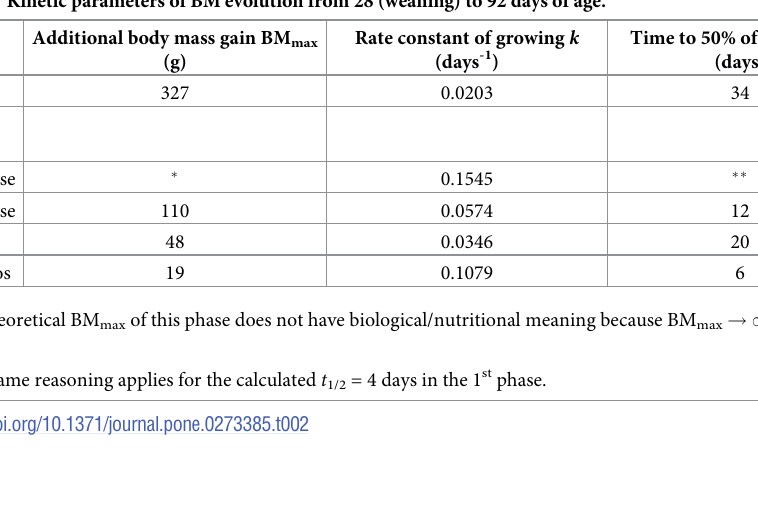
Table 2. Kinetic parameters of BM evolution from 28 (weaning) to 92 days of